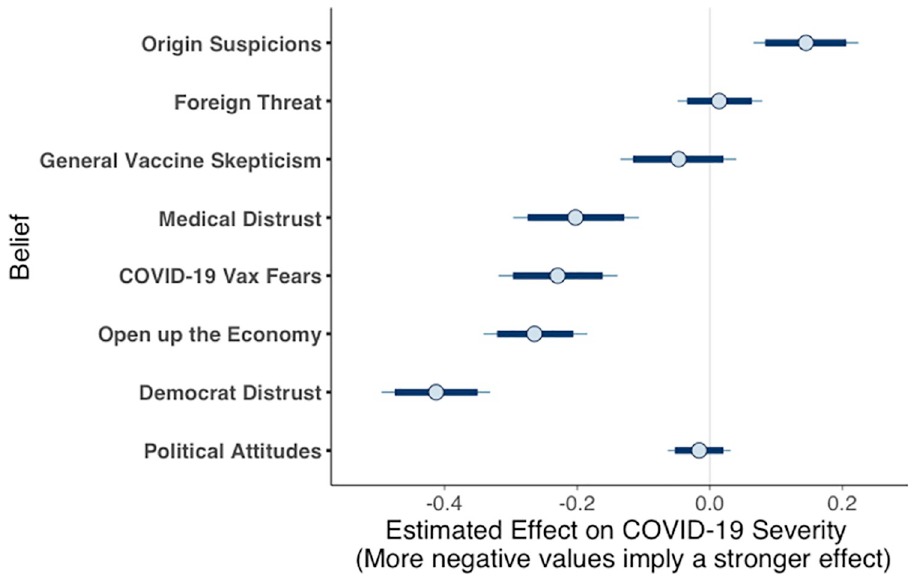
Fig 7. Posterior regression estimates for predictors of first-wave COVID-19